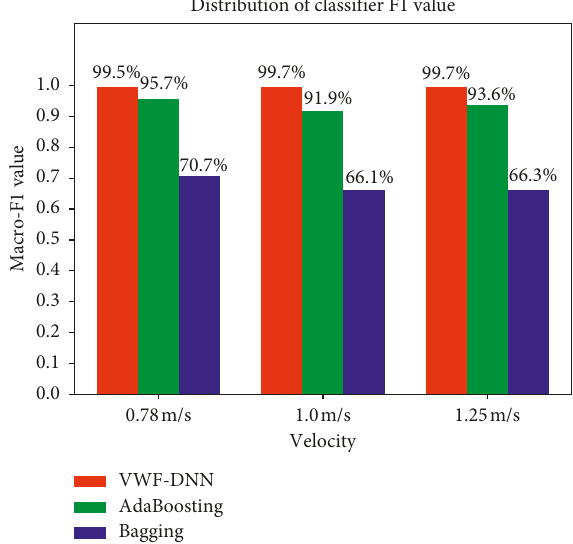
Figure 12: More tag data set classifier macro-F1 distribution under sync